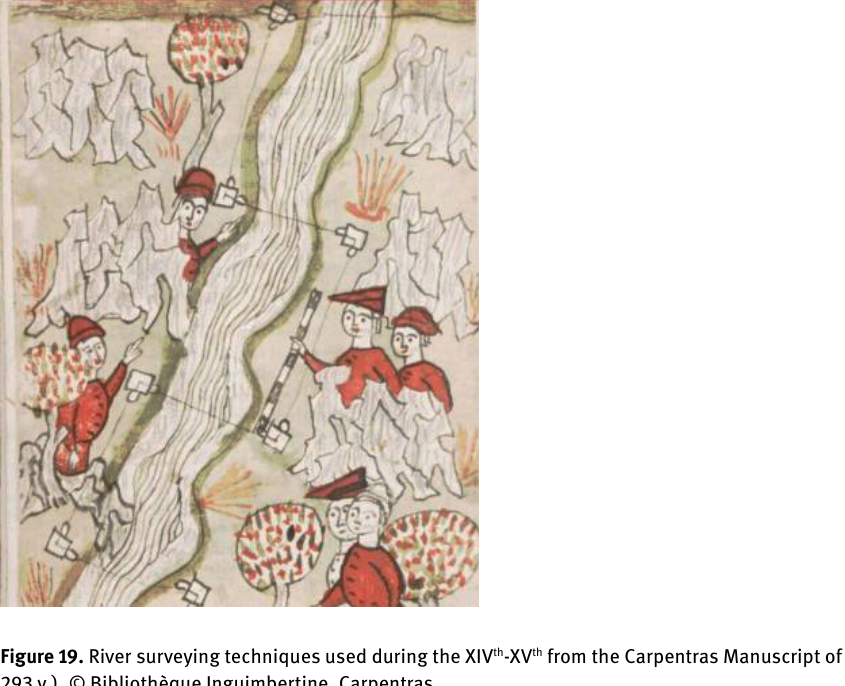
Figure 19. River surveying techniques used during the XIV th -XV th from the Carpentras Manuscript of Bertran Boisset (Ms. 327, f° 293 v.). © Bibliothèque Inguimbertine, Carpentras.